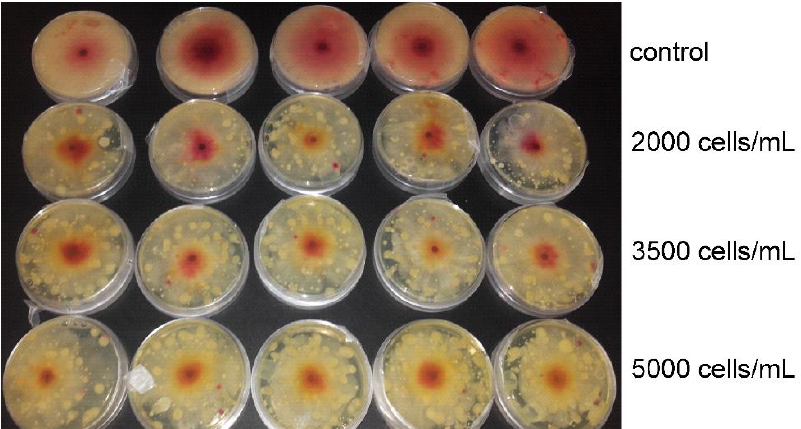
Figure 3. Petri dishes with Fusarium culmorum mycelium 48 h after treatment with Eisenia andrei coelomic fluid extract.